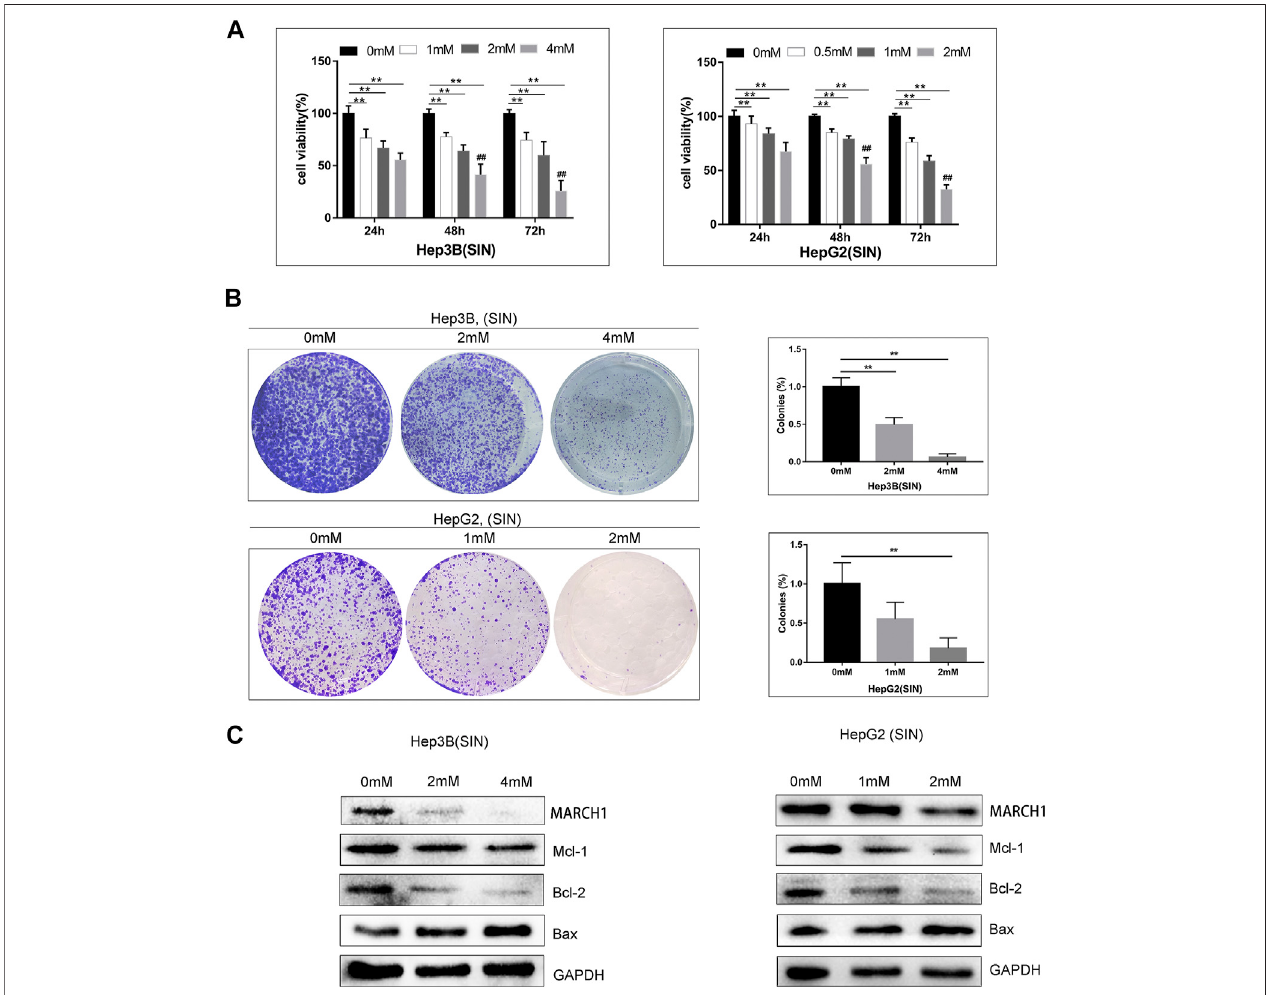
FIGURE 3 | SIN induced HCC cells apoptosis. (A) CCK-8 assay on the viability of Hep3B and HepG2 cells treated with SIN for 24, 48, and 72 h. 0 mM as control. (B) The Hep3B and HepG2 cells was treated with SIN (Hep3B: 0, 2, 4 mM; HepG2: 0, 1, 2 mM) for 36 h, and then incubated in fresh medium without SIN for 10 days. Thecolonieswere fi xedandstained.0 mMascontrol. (C) Theapoptosis-relatedsignalingmoleculesMcl-1,BaxandBcl-2testedinHep3BandHepG2cells.Alldataare means ± SD of results from three experiments. ** represents p < 0.01; ## indicates p <